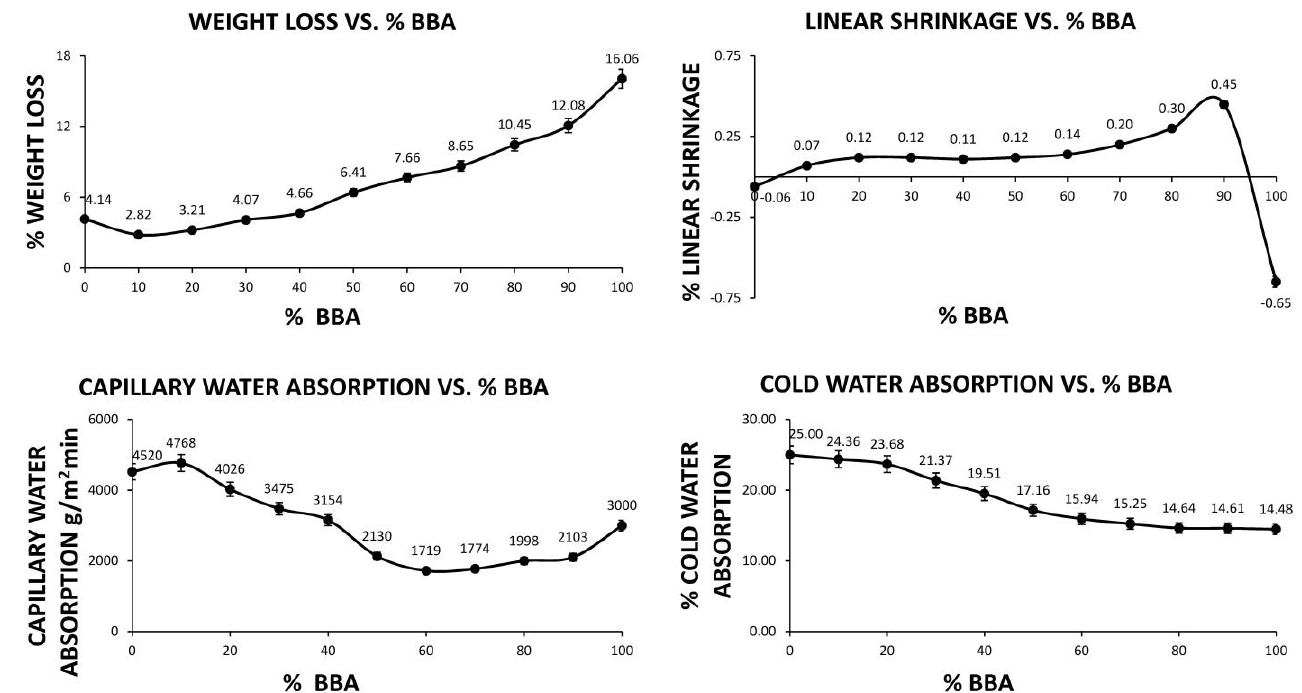
Figure 3. Graphs of the loss of weight, linear shrinkage, capillary water absorption and the cold water absorption of the different sample groups of geopolymers.